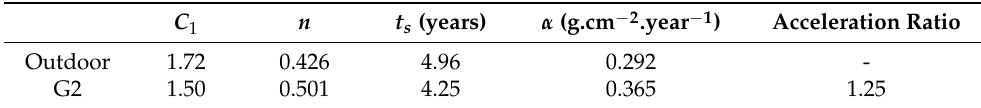
Table 10. Fitting parameters in corrosion kinetic models for mass loss results of outdoor exposure and experiment G2. C 1 n t s (years) α (g.cm − 2 .year − 1 ) Acceleration Ratio Outdoor